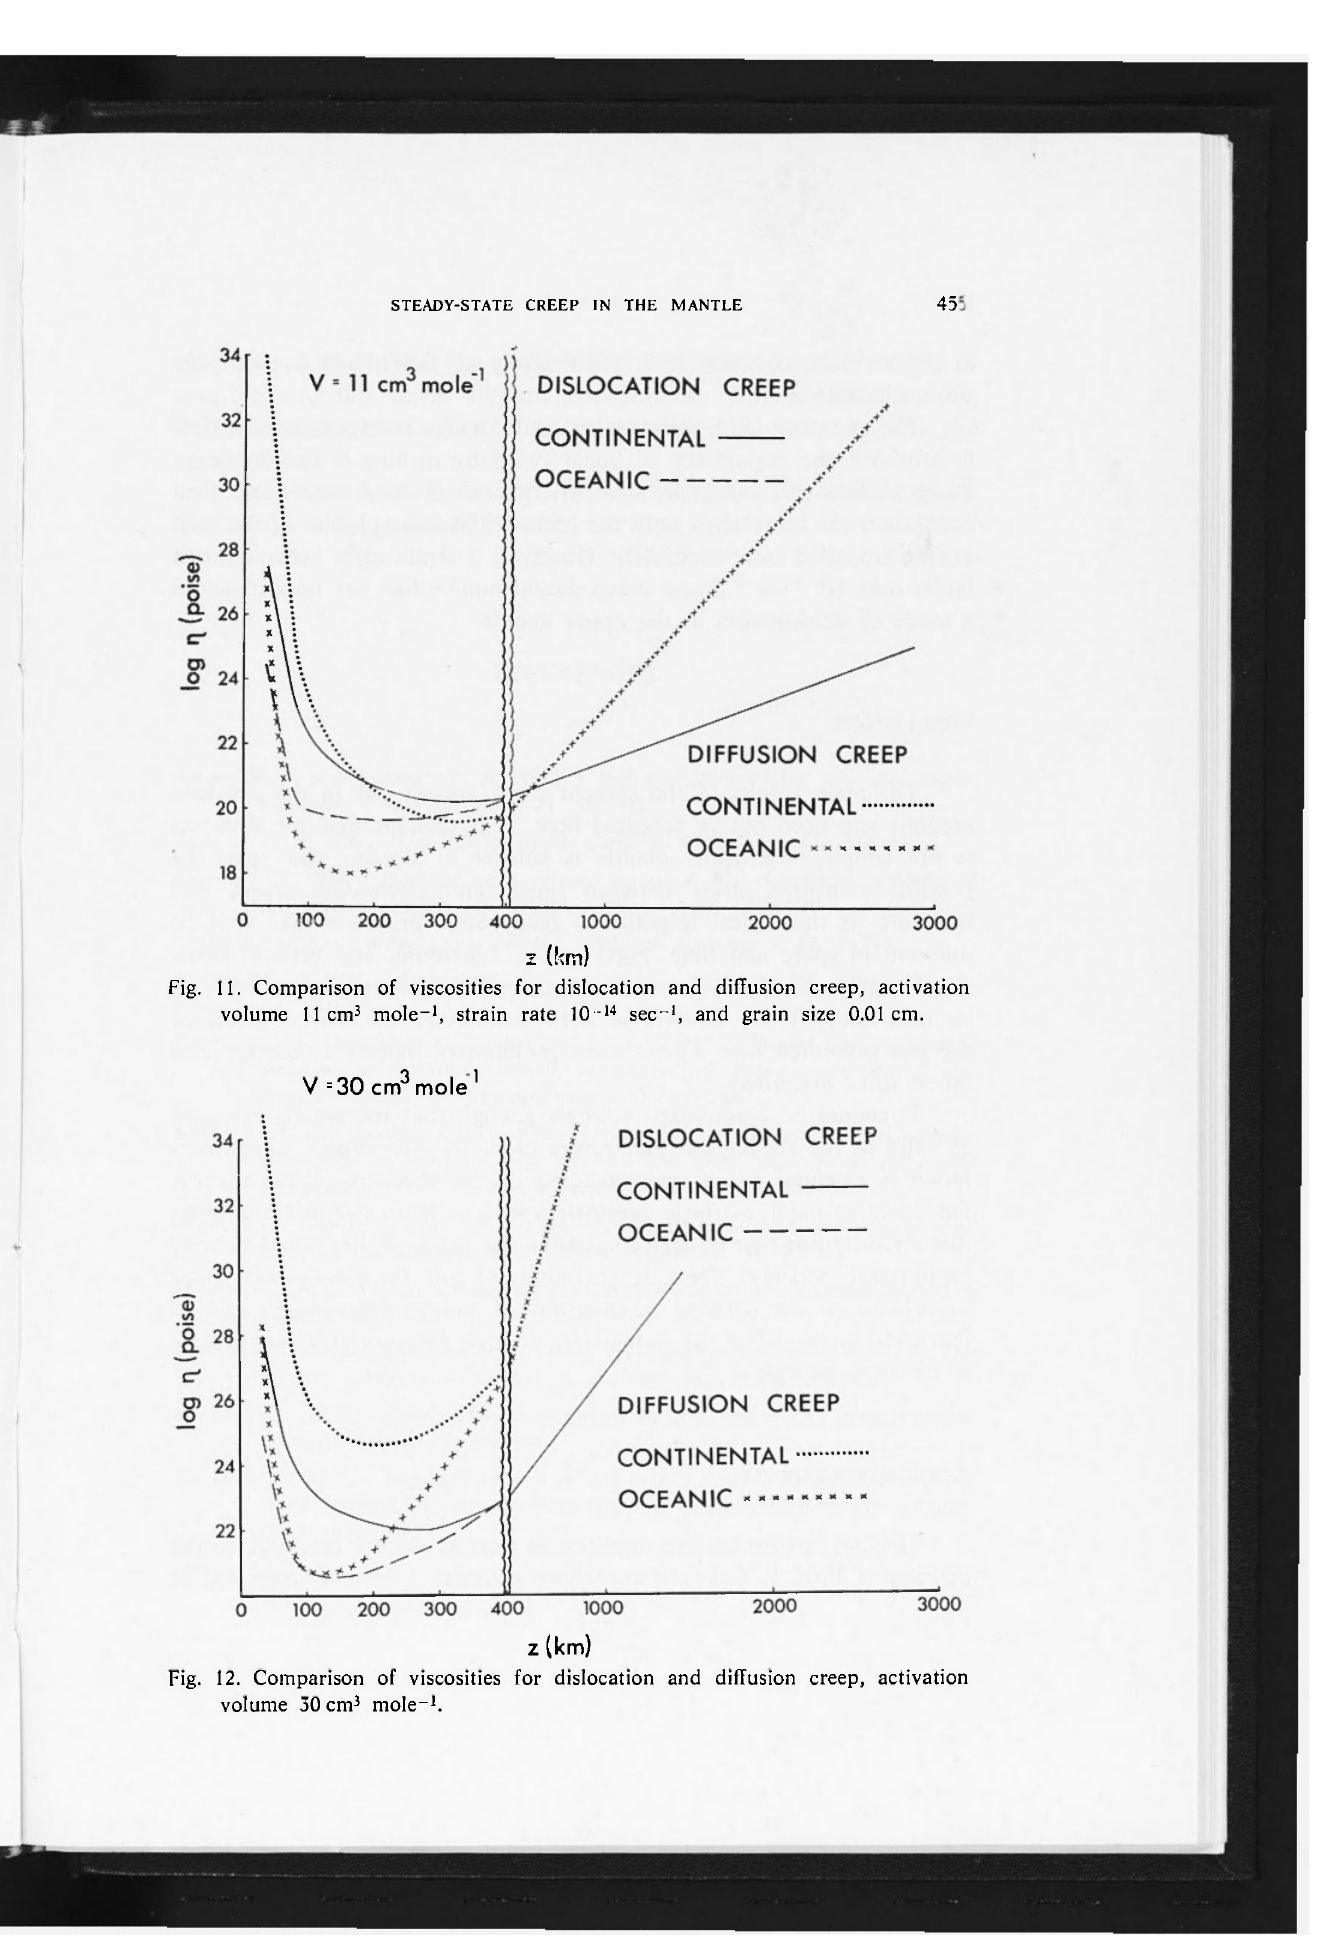
Fig. 12. Comparison of viscosities for dislocation and diffusion creep, activation volume 30 cm 3 mole -1